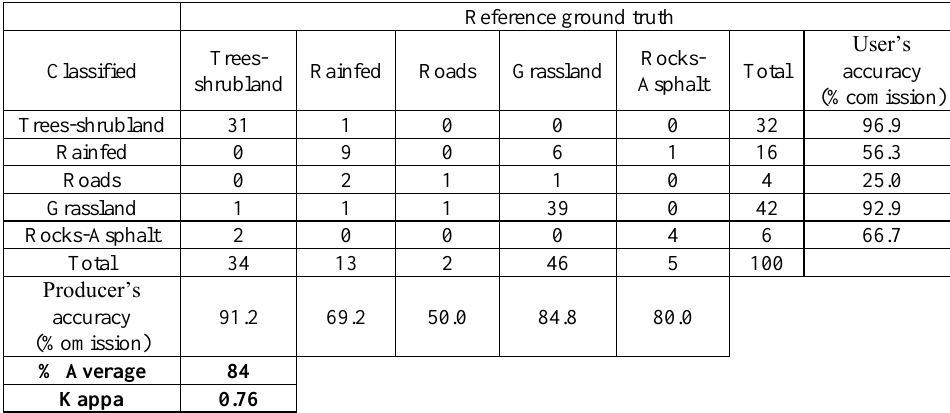
Table A. Accuracy assessment values for the confusion matrix of the